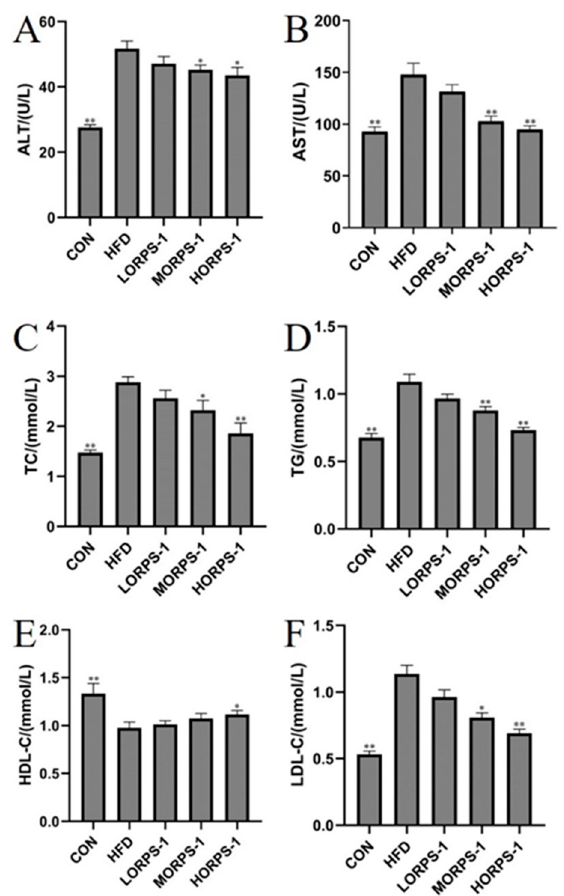
Figure 3. Effects of 16 weeks of ORPS-1 treatment on major serum indices in NAFLD mice. ( A ) ALT, ( B ) AST, ( C ) TC, ( D ) TG, ( E ) HDL-C, ( F ) LDL-C. Values are expressed as the mean ± SD. * p < 0.05, vs. HFD group; ** p < 0.01, vs. HFD group ( N = 10 mice/group). ALT, alanine transaminase; AST, aspartate aminotransferase; HDL-C, high density lipoprotein cholesterol; LDL-C, low density lipoprotein cholesterol; TC, total cholesterol; TG, triglyceride.